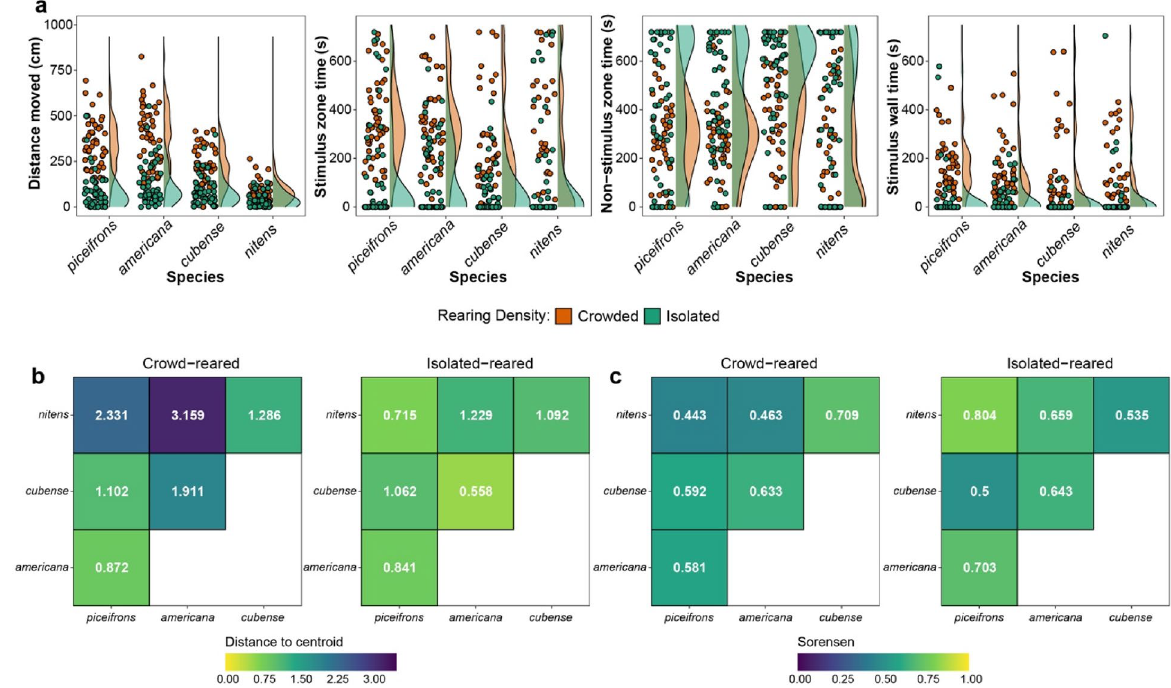
Figure 1. The behaviour of locust and non-swarming grasshopper species is influenced by rearing density, but varies among species. (a) Raincloud plots for four relevant behavioural variables in crowd-reared and isolated- reared nymphs of piceifrons, americana, cubense and nitens . The activity-related behaviour is ‘Distance moved’, in cm. The attraction-related behaviours are represented by three variables: ‘Stimulus zone time’, ‘Non-stimulus zone time’, and ‘Stimulus wall time’, all in seconds (s). Density curves show the general patterns for each rearing condition, while jittered points detail the observed data. ( b ) Heatmaps showing the distance to centroid for pairwise species comparisons of crowd-reared (left) and isolated-reared (right) nymphs. After a reduction of the behavioural data with a PCA, hypervolumes were generated for each combination of species and rearing density. Distance to centroid uses Euclidean distances to measure how different hypervolumes are. Shorter distances are shown with warmer colours approaching yellow, while larger distances are displayed as cooler colours approaching purple. (c) Heatmaps created using the same data and organization as (b) but visualizing overall similarity of each group with the Sorensen index. As before, warmer colours represent higher similarity and cooler colours represent less